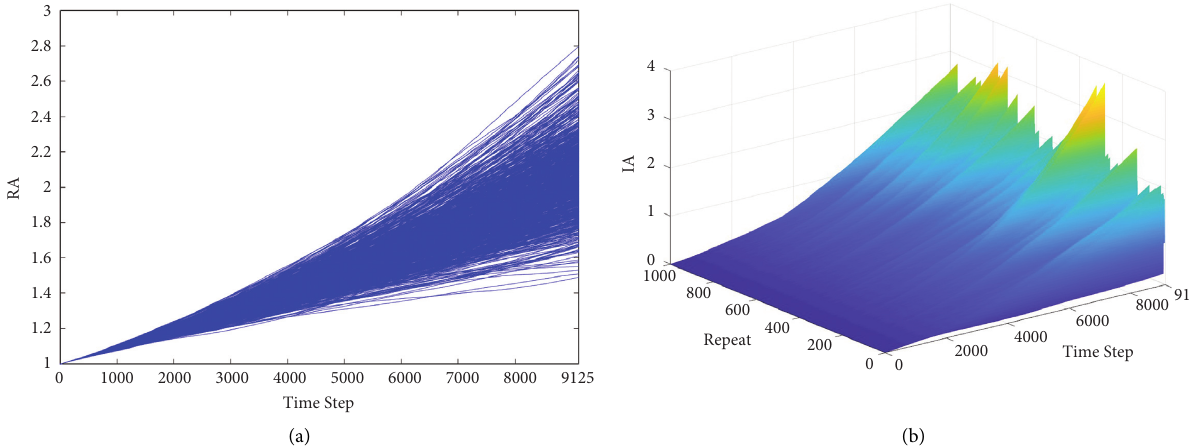
Figure 5: (a) The simulation results of the discount operator (RA) and (b) inflation operator (IA) simulation result graph.